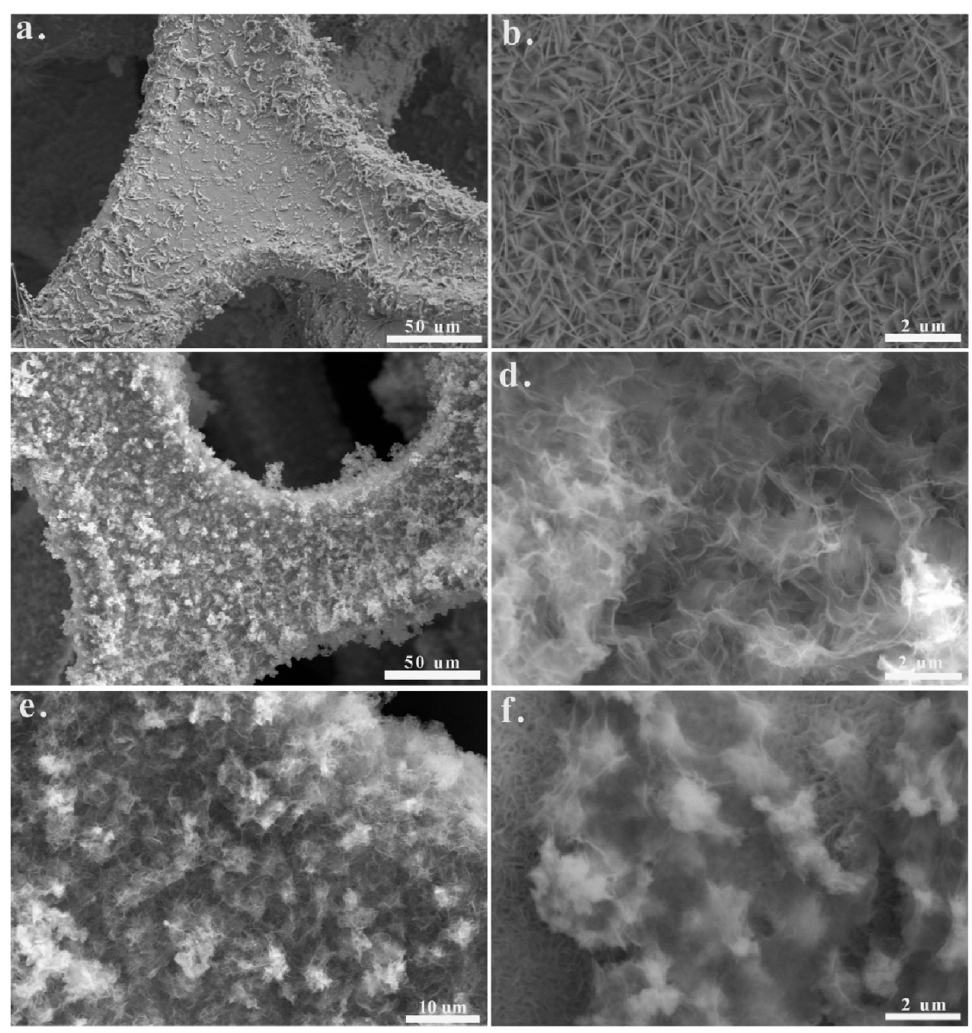
Figure 9. ( a , b ) SEM images of CoMoO 4 with different magnification; ( c , d ) SEM images of CoS with different magnification; ( e , f ) SEM images of CoMoO 4 @CoS with different magnification. Reproduced with permission from [181]. Copyright 2020 Elsevier.